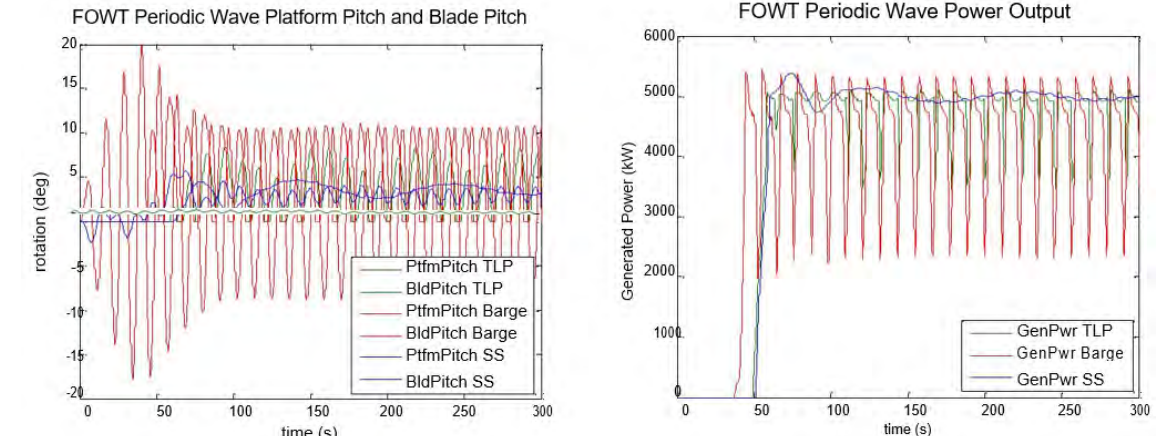
Figure 7. Platform vs Blade Pitch Responses (Left) and the Power Output (Right) for Periodic Wave Case